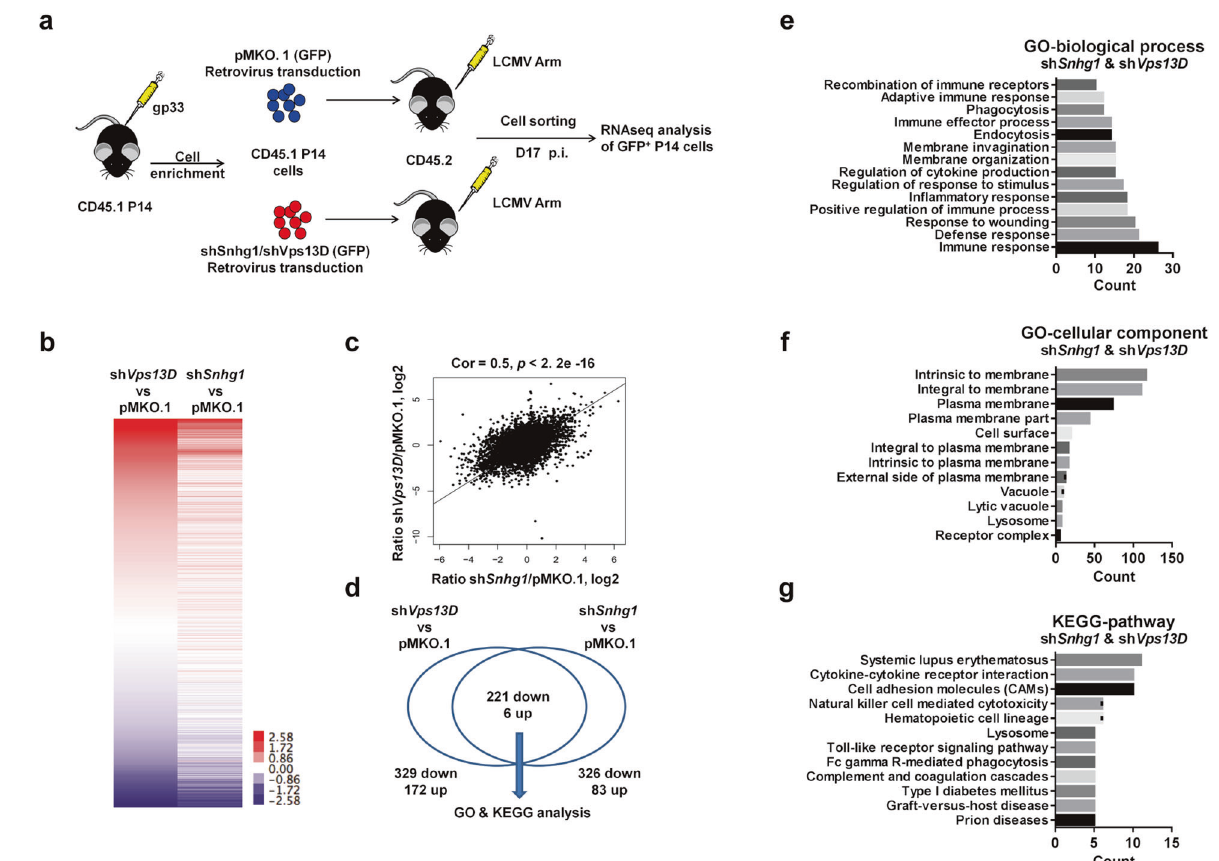
Fig. 4 Genes modulated by Snhg1 and Vps13D in T cells mainly involve in membrane receptor-associated immune processes. a The gp33 activated P14 CD8 T cells from CD45.1 mice were enriched and transducted with a retrovirus containing sh Snhg1/shVps13D or control vector, thus adoptively transferred into CD45.2 mice and the GFP + P14 CD8 T cells were sorted for RNA-seq analysis on day 17 post-infection. b Heatmap of the genes regulated by sh Snhg1 or sh Vps13D compared with the control pMKO.1 group. c Correlation analysis between normalized genes expression ratio of sh Snhg1 /pMKO.1 and sh Vps13D /pMKO.1 with Pearson ’ s correlation coef fi cient. d Venny diagram of shared upregulated or downregulated genes in sh Snhg1 and sh Vps13D group. e – g GO and KEGG analysis of shared downregulated genes between sh Snhg1 and sh Vps13D group in biological processes, cellular components and pathways. Data are obtained from one experiment with two biological replicates pooled from at least four mice per group. See also Fig. S4, Tables S1, 3,